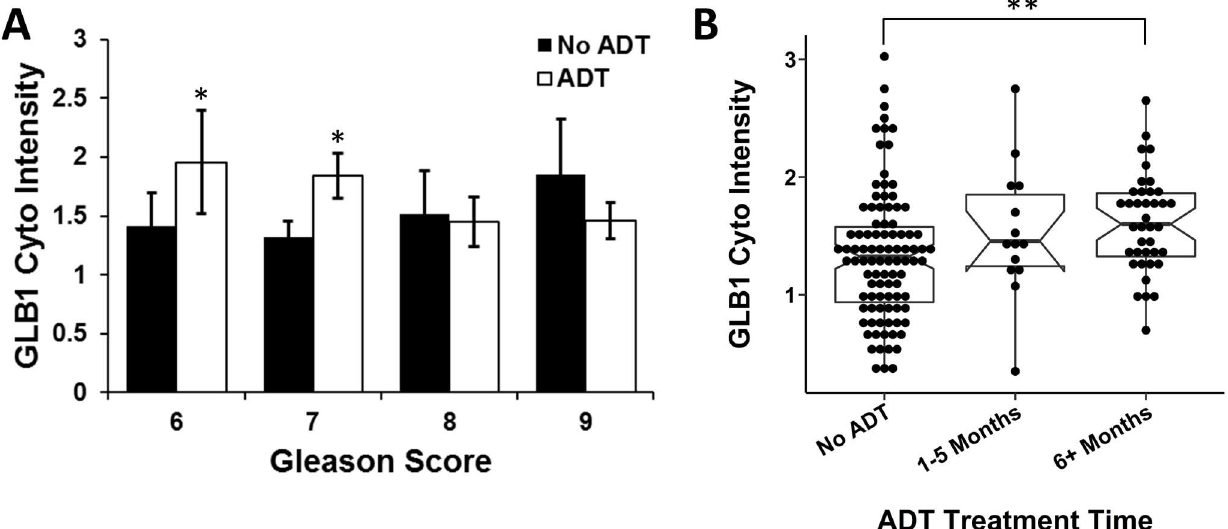
Fig 2. GLB1 levelsincreaseafter ADT in intermediategradePCaand overtime. (A) GLB1 expressionwas measured in radicalprostatectomy specimenscategorized by ADTstatus andpretreatment Gleasongrade.Higherlevelsof GLB1 wereexpressedin intermediate PCatissuestreated with ADT. GLB1after ADTwas not increased in highgradecancers(Gleason8 + 9). (B) GLB1 expressionwas evaluated over neoadjuvant ADT treatment duration.PCatissuesexposedto ADT longerthan5 monthsexpressed significantlyhigherlevelsof GLB1 compared to no ADT,